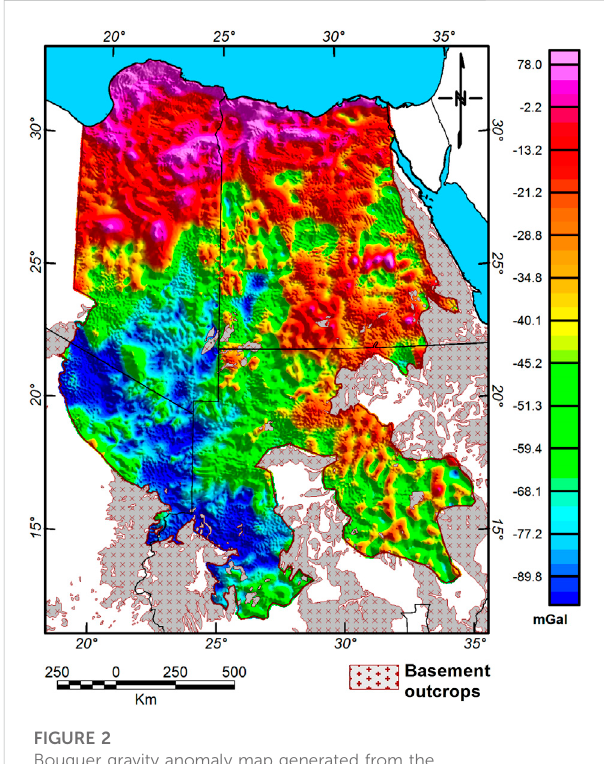
EGM2008 data (Pavlis et al., 2012) over the study